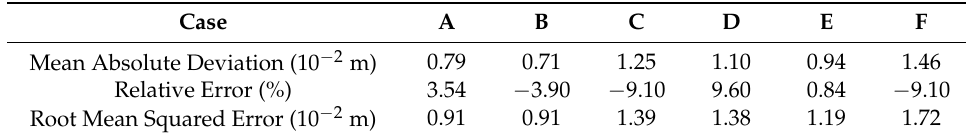
Table 3. Wave profiles comparison with the experimental